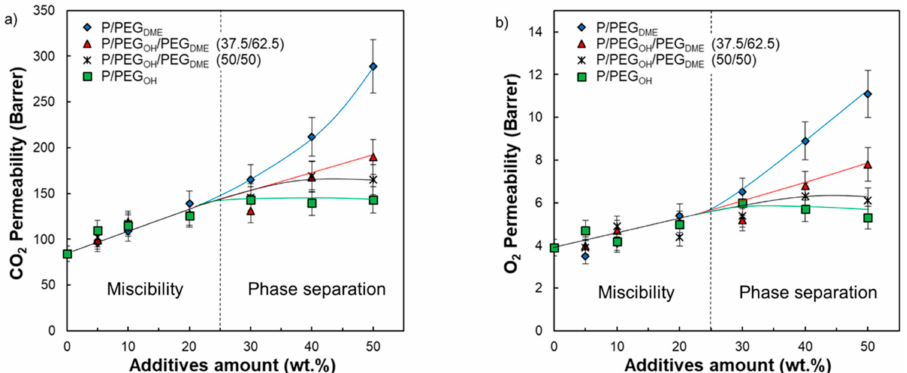
Figure 13. Evolution of the CO 2 permeability coefficient ( a ) and the O 2 permeability coefficient ( b ) as a function of the additive amount for each Pebax ® /PEG